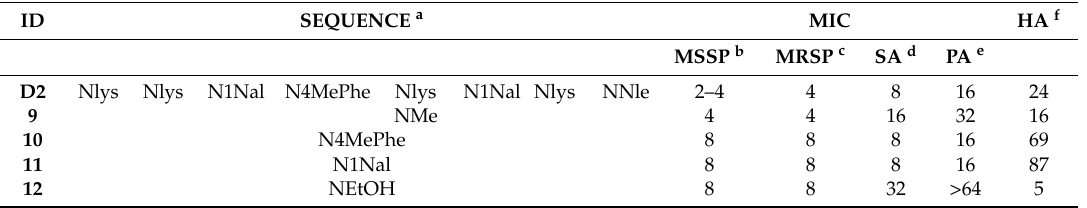
Table 2. Effect of single substitutions in position 5 on antibacterial (MIC, µ g/mL) and hemolytic activity (% at 150 µ M) of D2 .